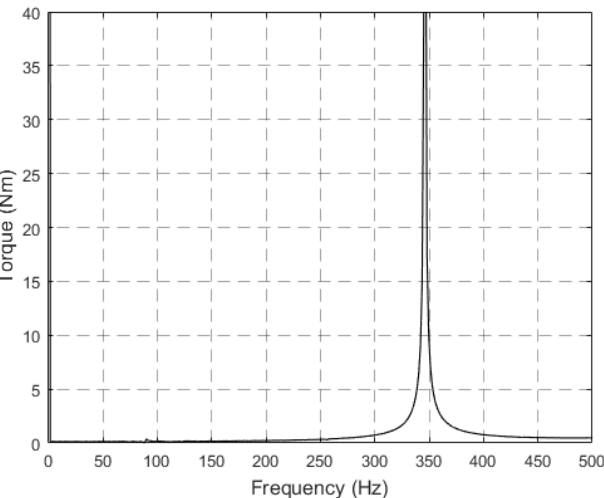
Figure 19. The torque amplitude frequency spectrum, synchronous DTC scheme, f ∈ [0, 500 Hz]. ω m * = 0.8 ω N .